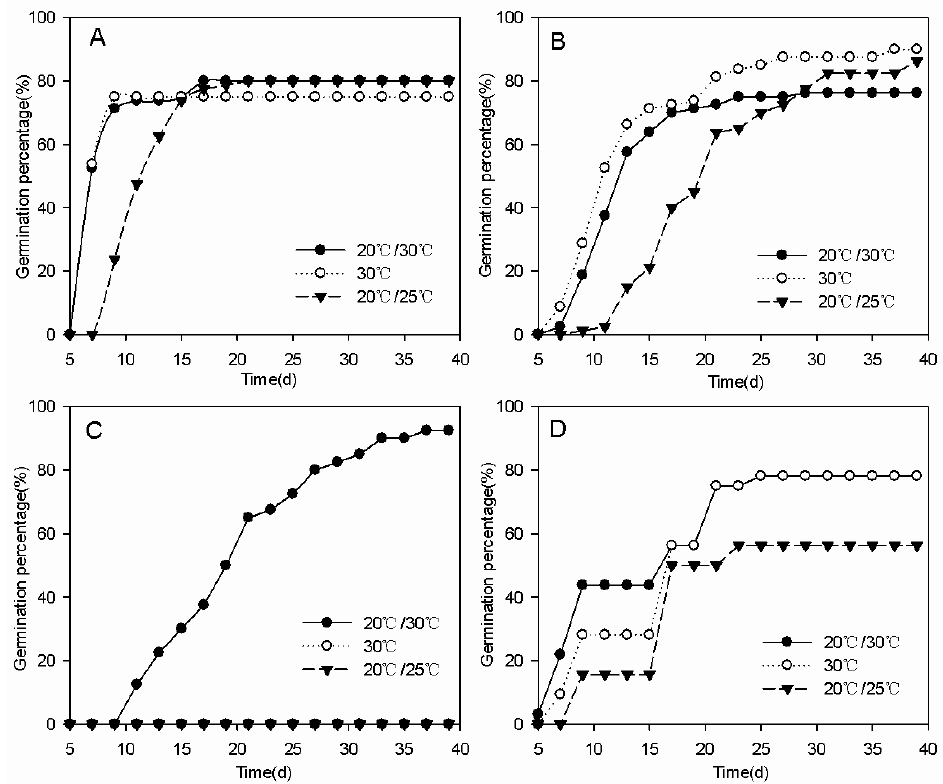
Figure 8. Effect of temperature on seed germination of species with different ecological forms. Germination curves of ( A ) Thysanolaena maxima , ( B ) Melastoma sanguineum , ( C ) Trema tomentosa , and ( D ) Cryptocarya chinensis under different temperatures.